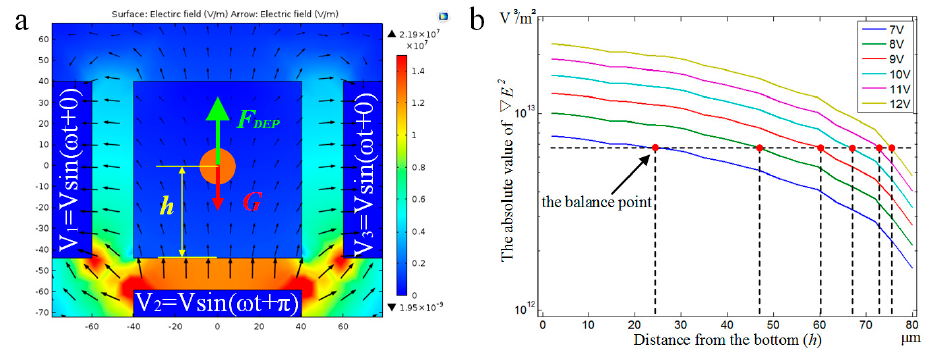
Figure 6. Levitation of cell to overcome the sinking problem. ( a ) Side view of electric field strength distribution of the chamber. ( b ) The value of (cid:12) ∇ E 2 (cid:12) for different heights of the cell and bottom electrode.